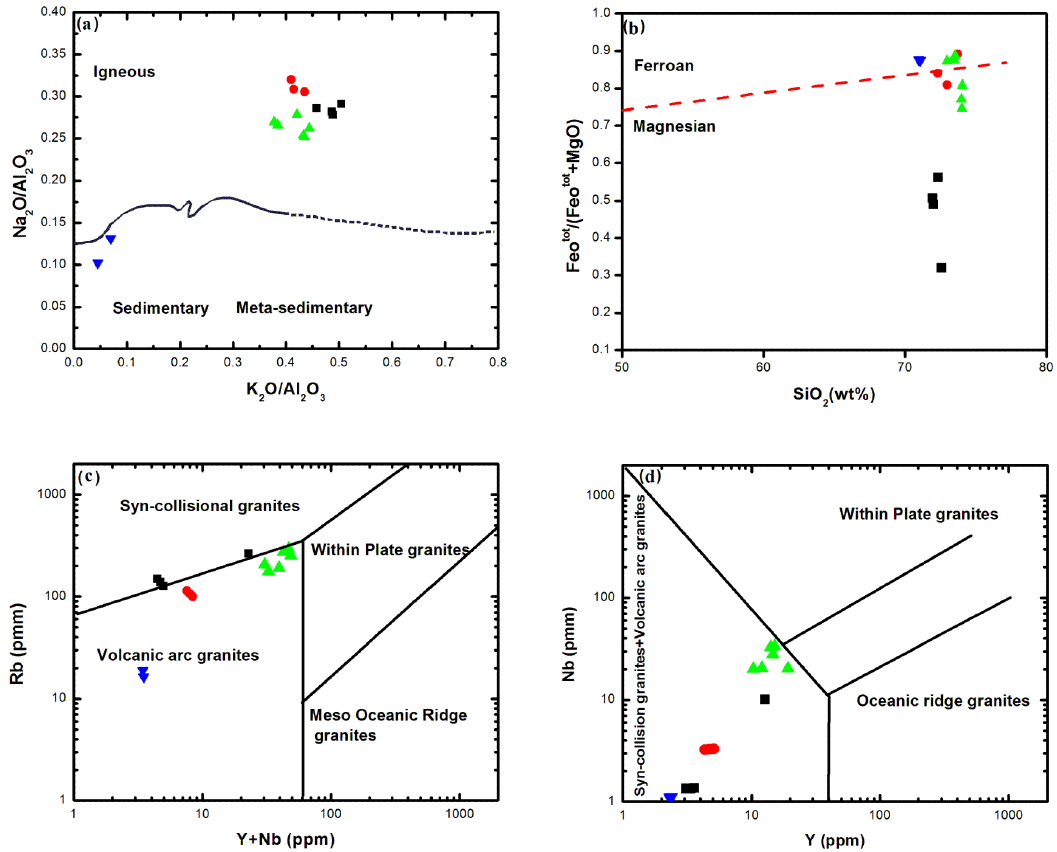
Figure 7. ( a ) Na 2 O/Al 2 O 3 vs. K 2 O/A1 2 O 3 diagram of [57] for the Tianshui granitoids and Roche type rock, ( b ) position of the granitoids and Roche type rock of the Tianshui area in the SiO 2 vs. FeOt/(FeOt + MgO) diagram, ( c ) tectonomagmatic discrimination diagrams of [58] using Y + Nb (ppm) vs. Rb (ppm) and ( d ) Y (ppm) vs. Nb (ppm).